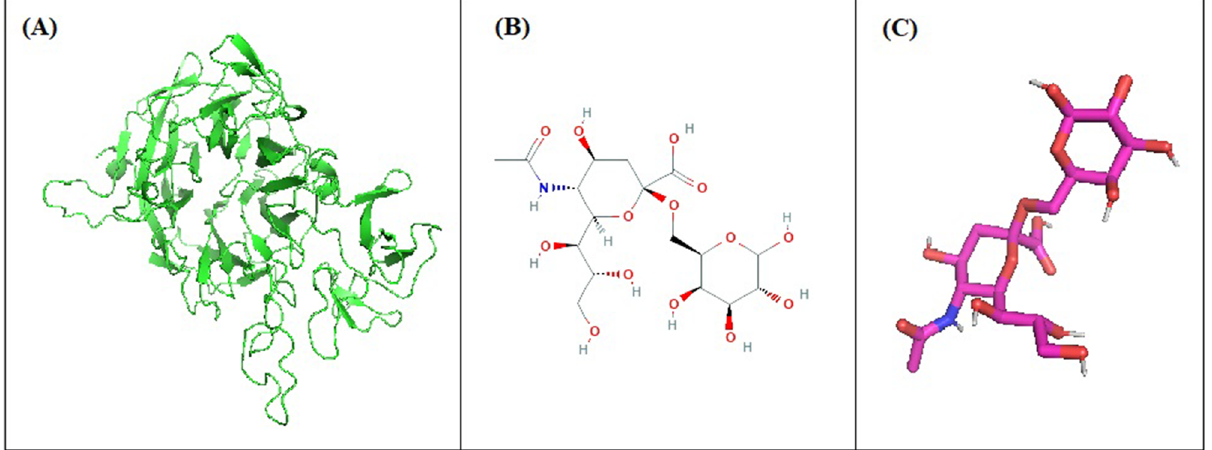
Figure 1. Some of the structures required in the docking process. ( A ) NanB sialidase protein generated from the Raptor X program; ( B ) 2D structure of Neu5Acα(2–6)Gal; ( C ) Neu5Acα(2–6)Gal 3D structure.